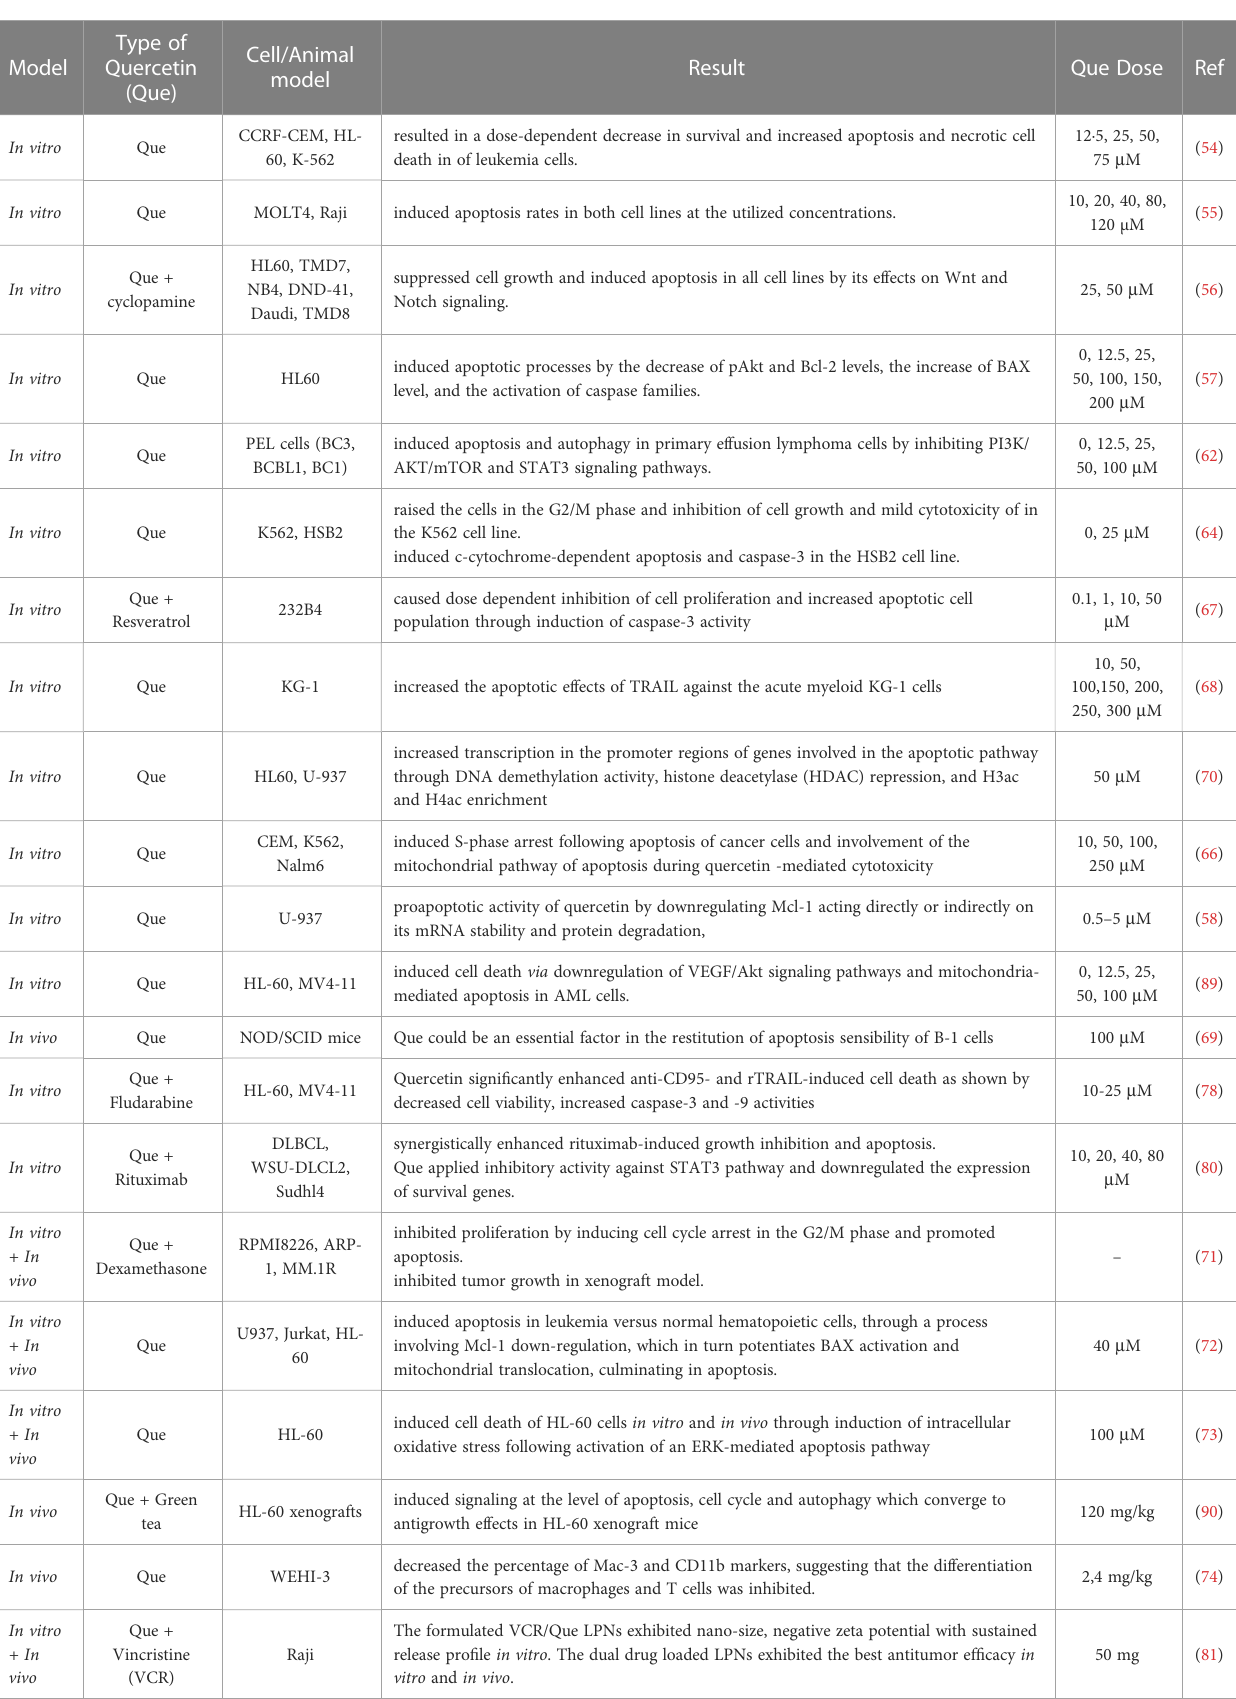
TABLE 1 The therapeutic effects of quercetin on blood cancer.